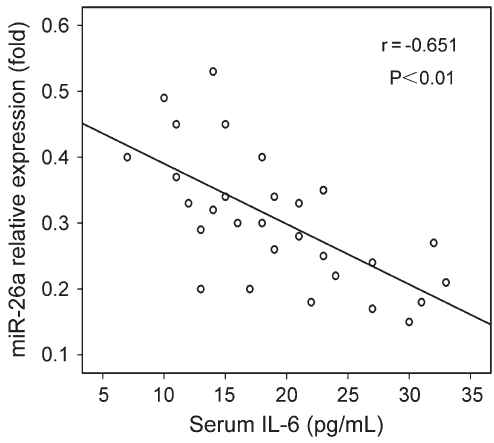
Figure 2. Correlation between serum IL-6 concentration and miR- 26a expression in hepatocellular carcinoma. The Pearson correla- tion test showed that the correlation was -0.651 (P ,